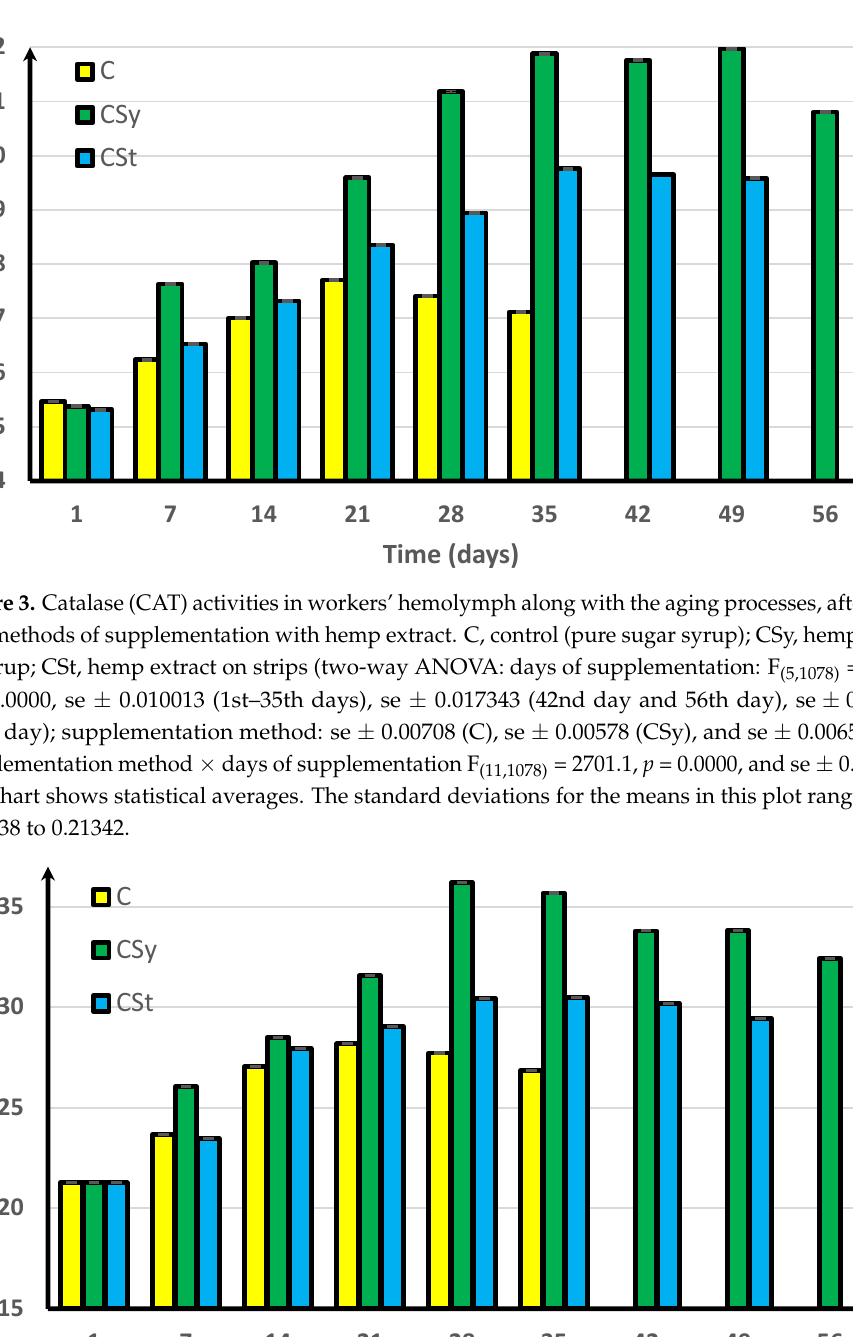
deviations for the means in this plot ranged from 0.04158 to 0.31201.